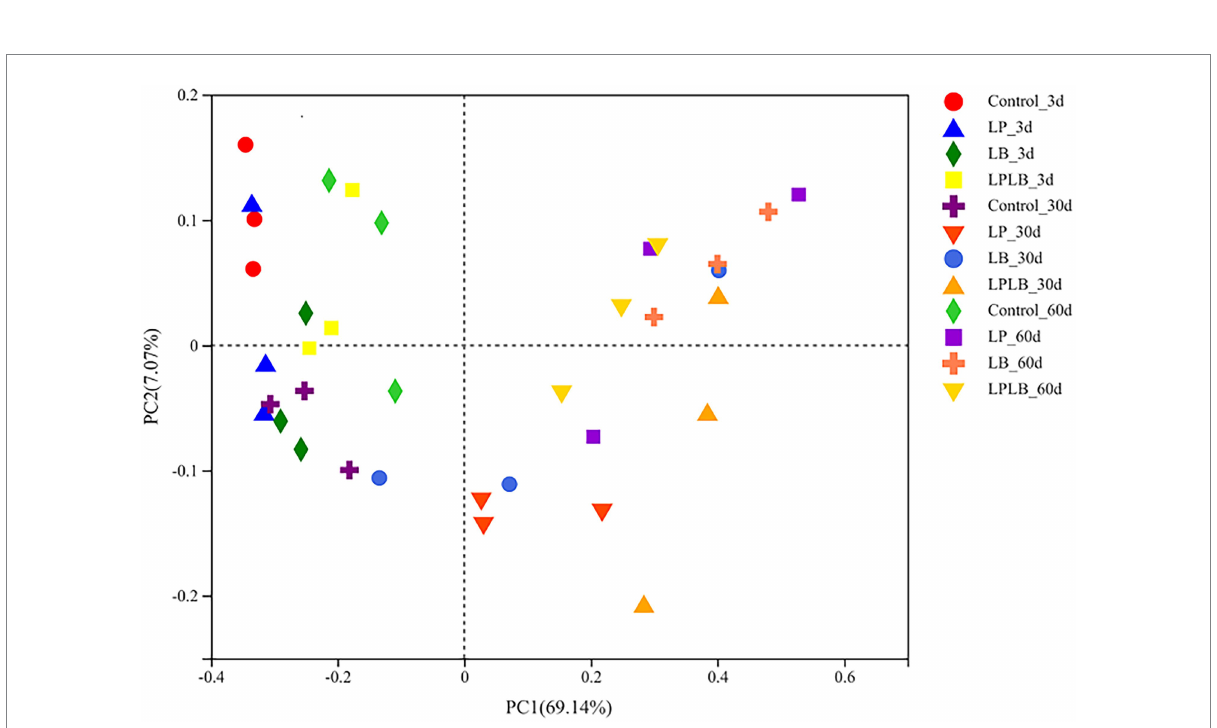
FIGURE 2 Principal-coordinate analysis (PCoA) plots based on weighted UniFrac distance for the bacterial community. Control, ensiling with no inoculant applied; LP, inoculated with Lactiplantibacillus plantarum ; LB, inoculated with Lactiplantibacillus brevis ; LPLB, inoculated with L. plantarum and L. brevis